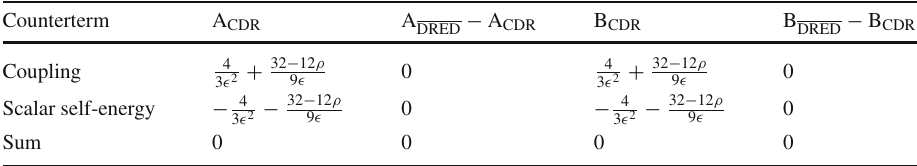
Table 5 Counterterm results for scalar QED using CDR and DRED,